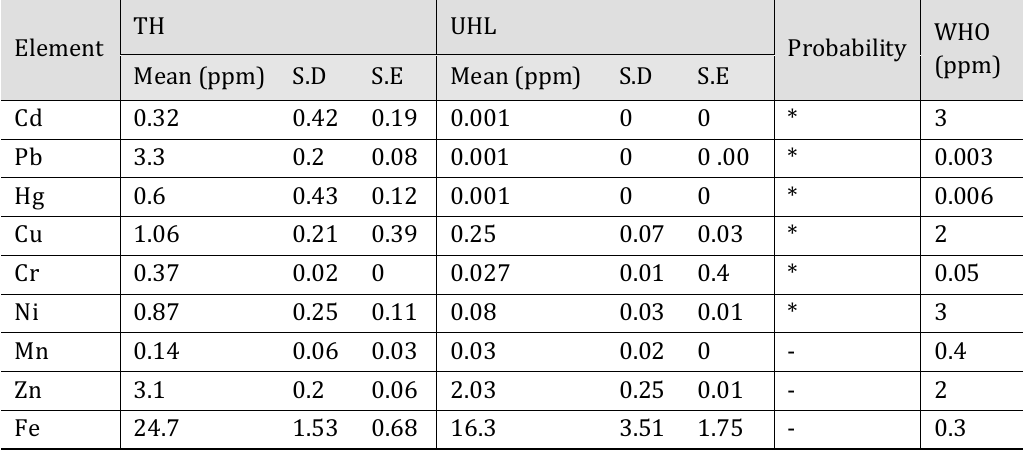
Table 2. Mean concentrations of heavy metals (± Standard deviation) in waters of